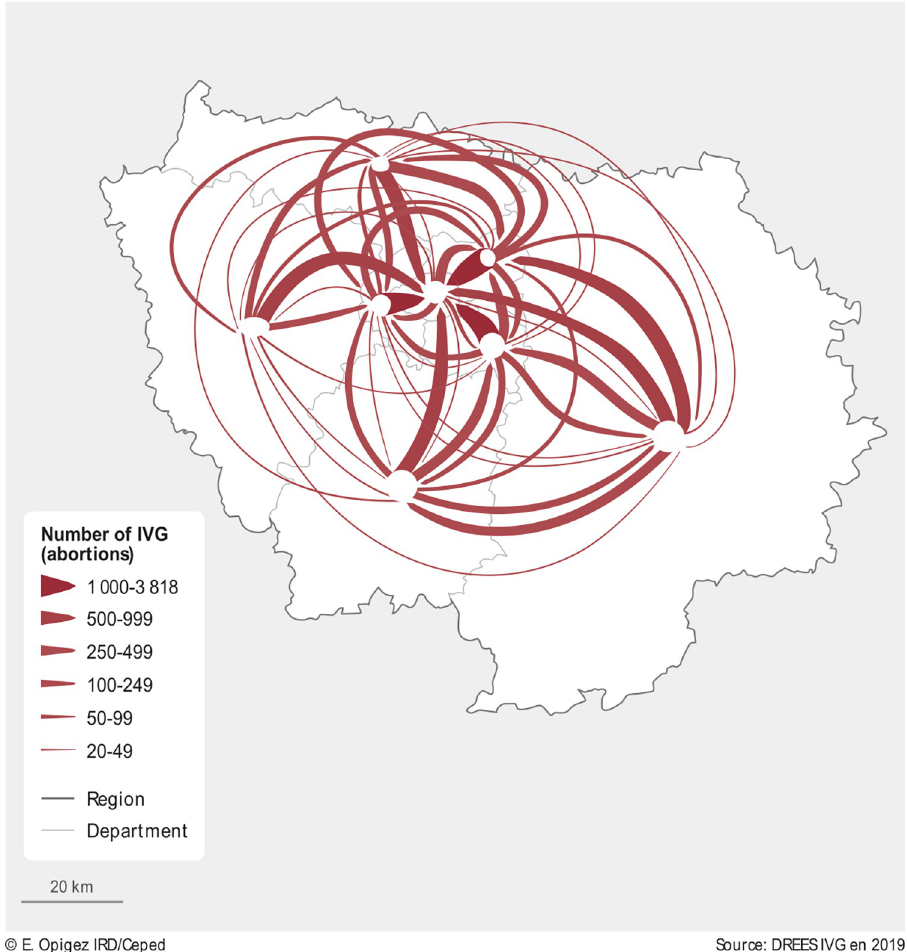
Fig 3. Abortion mobility, Iˆle-de-France Region, 2019. Source: [11]. Map produced by